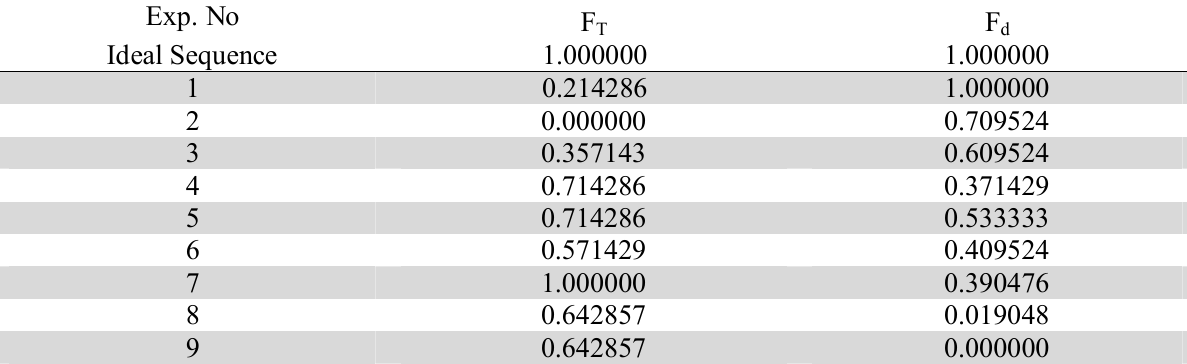
Grey relational generations Exp.